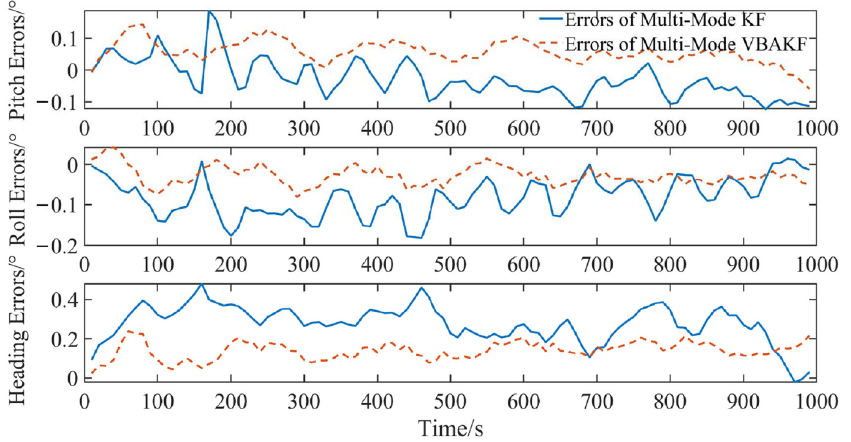
Figure 8. Comparison of filtering results with interference evaluation and multi-mode switching algorithms.